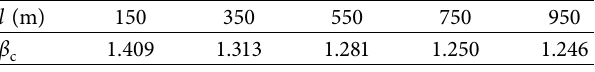
Figure 10: Influence of span ( l ) on the windage yaw angle ( φ ). Table 7: Influence of span on the dynamic wind load factor of the windage yaw angle.